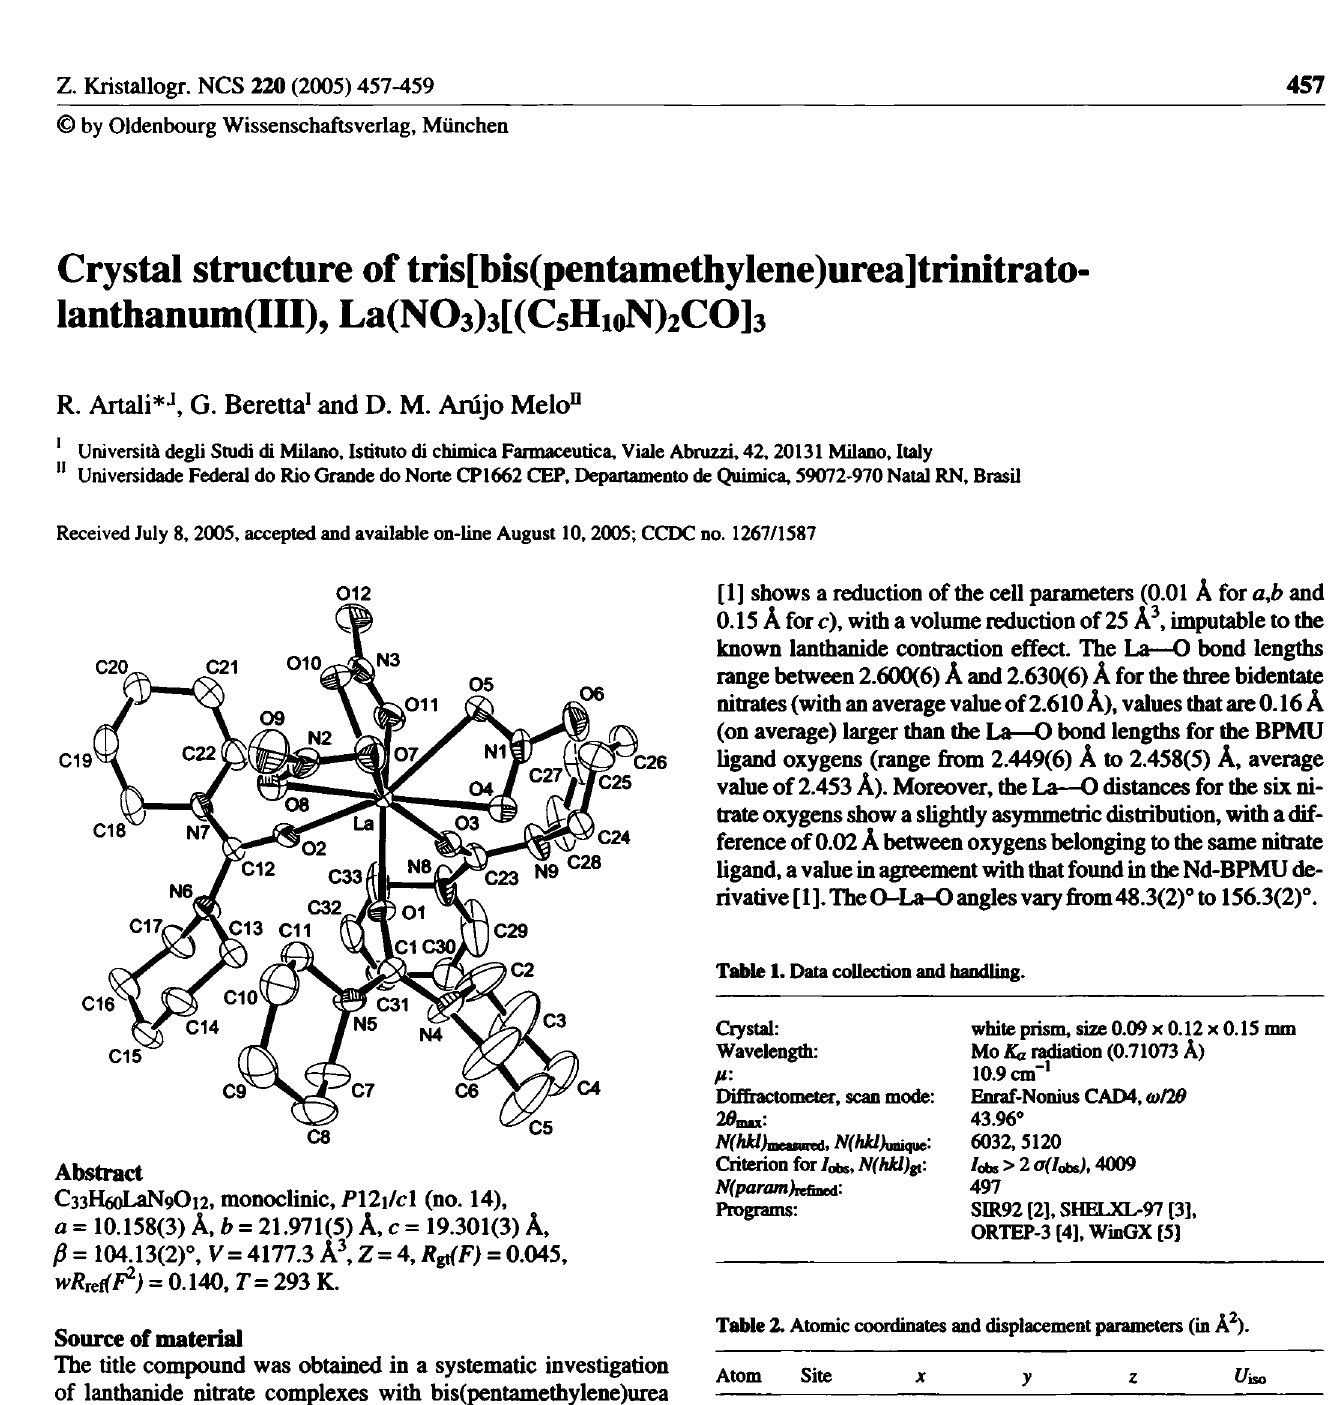
Table 2. Atomic coordinates and displacement parameters (in A 2